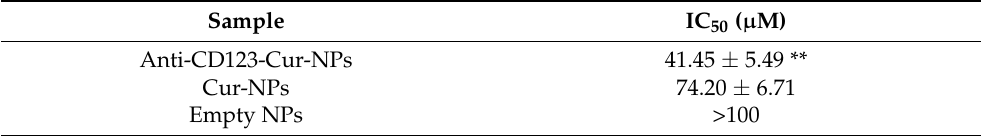
Table 2. Cytotoxicity of curcumin nanoparticles and empty nanoparticles in KG-1a cells. Sample IC 50 ( µ M)